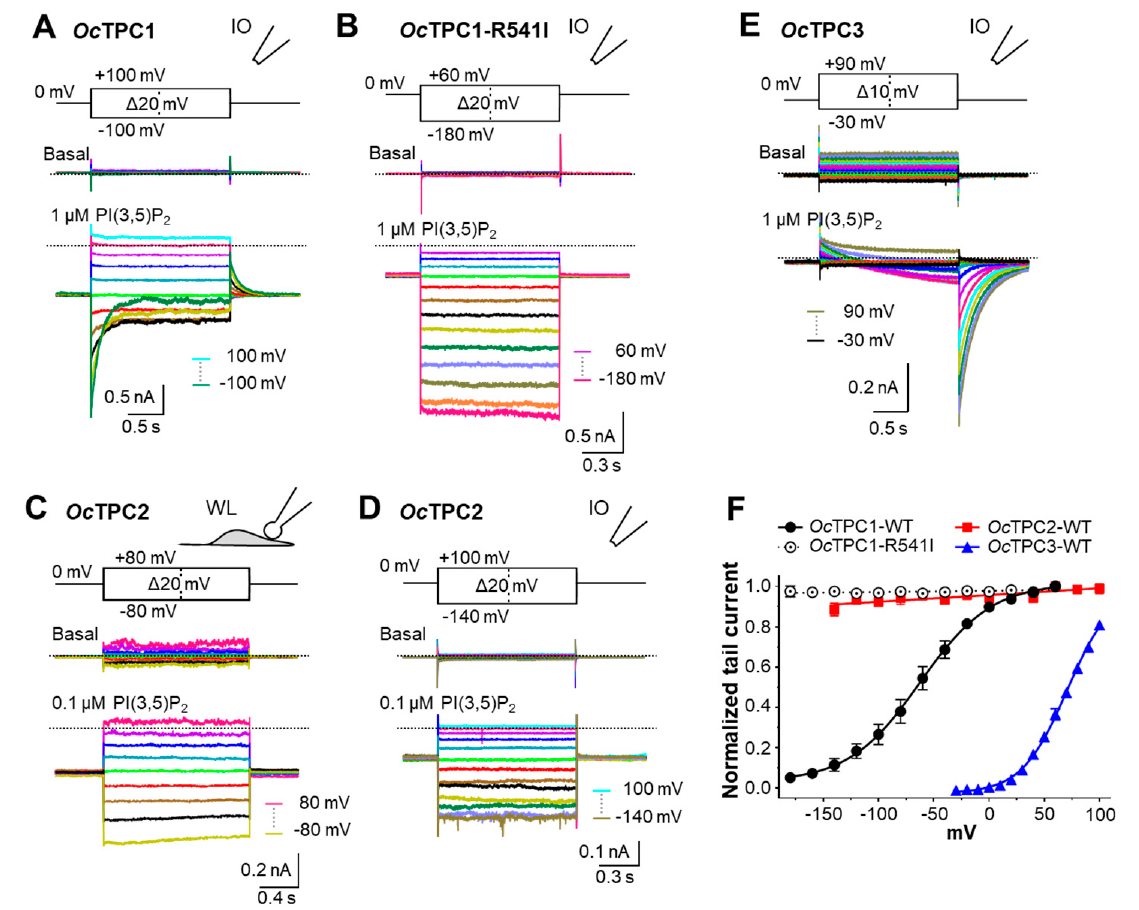
Figure 5. The three rabbit TPC isoforms display different voltage dependence. HEK293 cells were transiently transfected with cDNA coding for Oc TPC1-EGFP, Oc TPC1-R540I-EGFP, Oc TPC2-EGFP, or Oc TPC3-EGFP. ( A , B ) Representative currents elicited by voltage steps from − 100 mV to +100 mV with 20-mV increments ( A , see inset) and from − 180 mV to +60 mV with 20-mV increments ( B , see